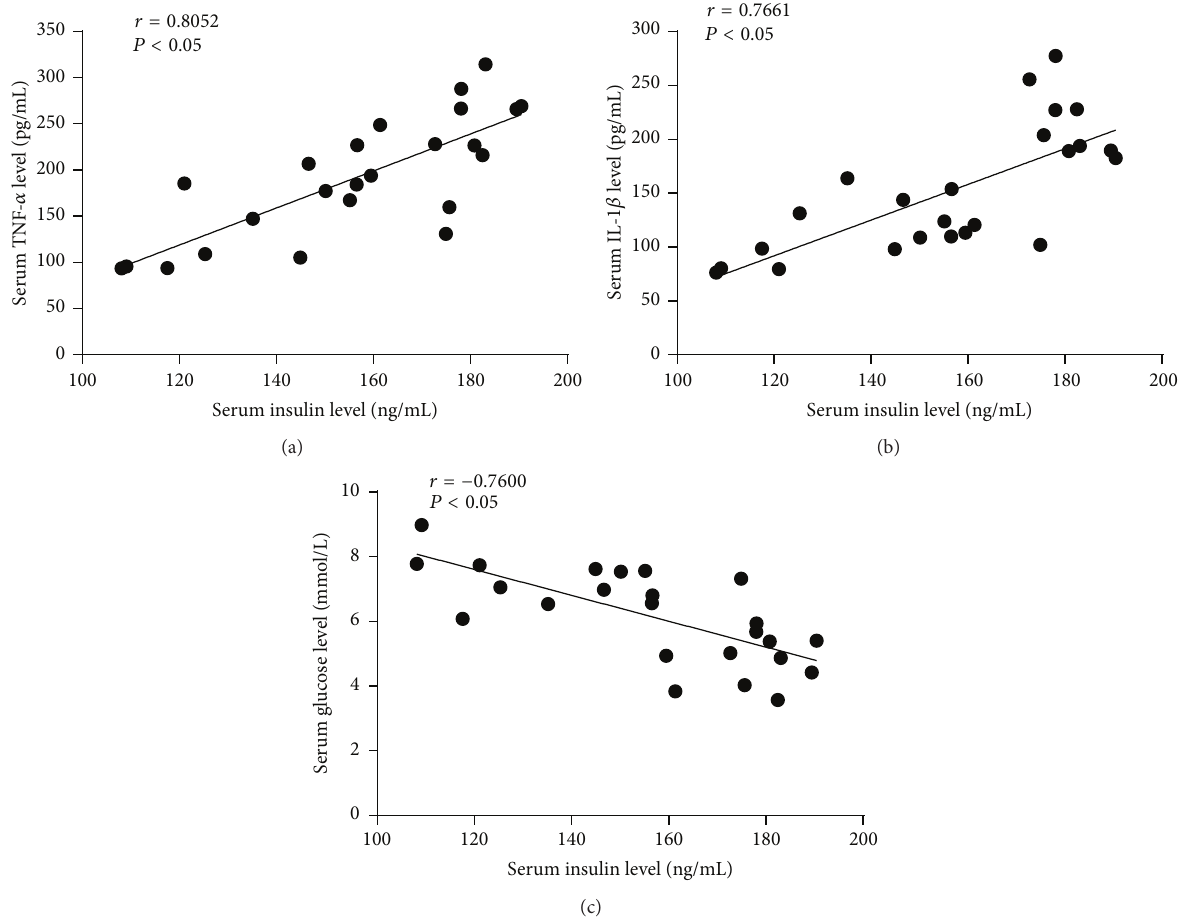
Figure 5: The correlations of serum insulin with TNF- 𝛼 , IL-1 𝛽 , and glucose were analyzed using Spearman correlation test. (a) Spearman correlation between insulin and TNF- 𝛼 ; (b) Spearman correlation between insulin and IL-1 𝛽 ; (c) Spearman correlation between insulin and